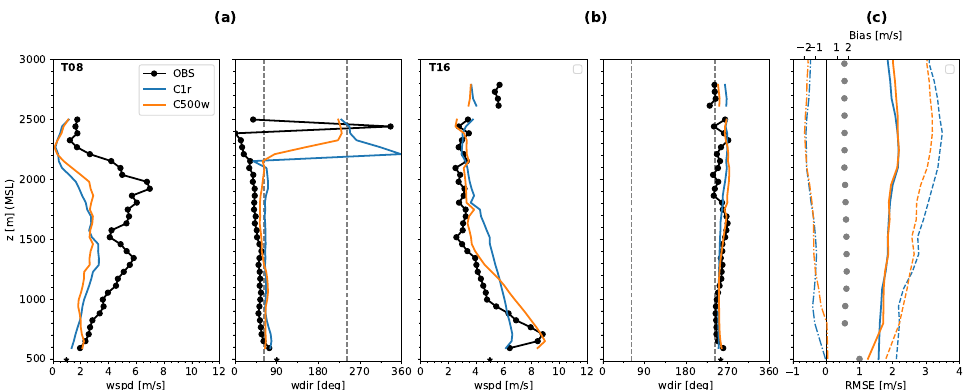
Figure 7. Vector-averaged profiles of the mean ( a ) down-valley wind at 08:00 and ( b ) up-valley wind at 16:00, for the valley wind days for observations (low-mode wind profiler) and simulations (C1r and C500w) for the location of Sion; ( c ) bias and mean absolute error (MAE) of hourly wind speeds (solid) and hourly wind velocities (dashed) during the 18 valley wind days with respect to the high-mode wind profiler. Grey points represent the data availability, which at the surface is 100%. Note that the high-mode data are used for the statistics (including data availability) due to poor data availability of the low-mode data at higher elevations, but the low-mode data is used for the profiles in order to resolve the low-level jet.